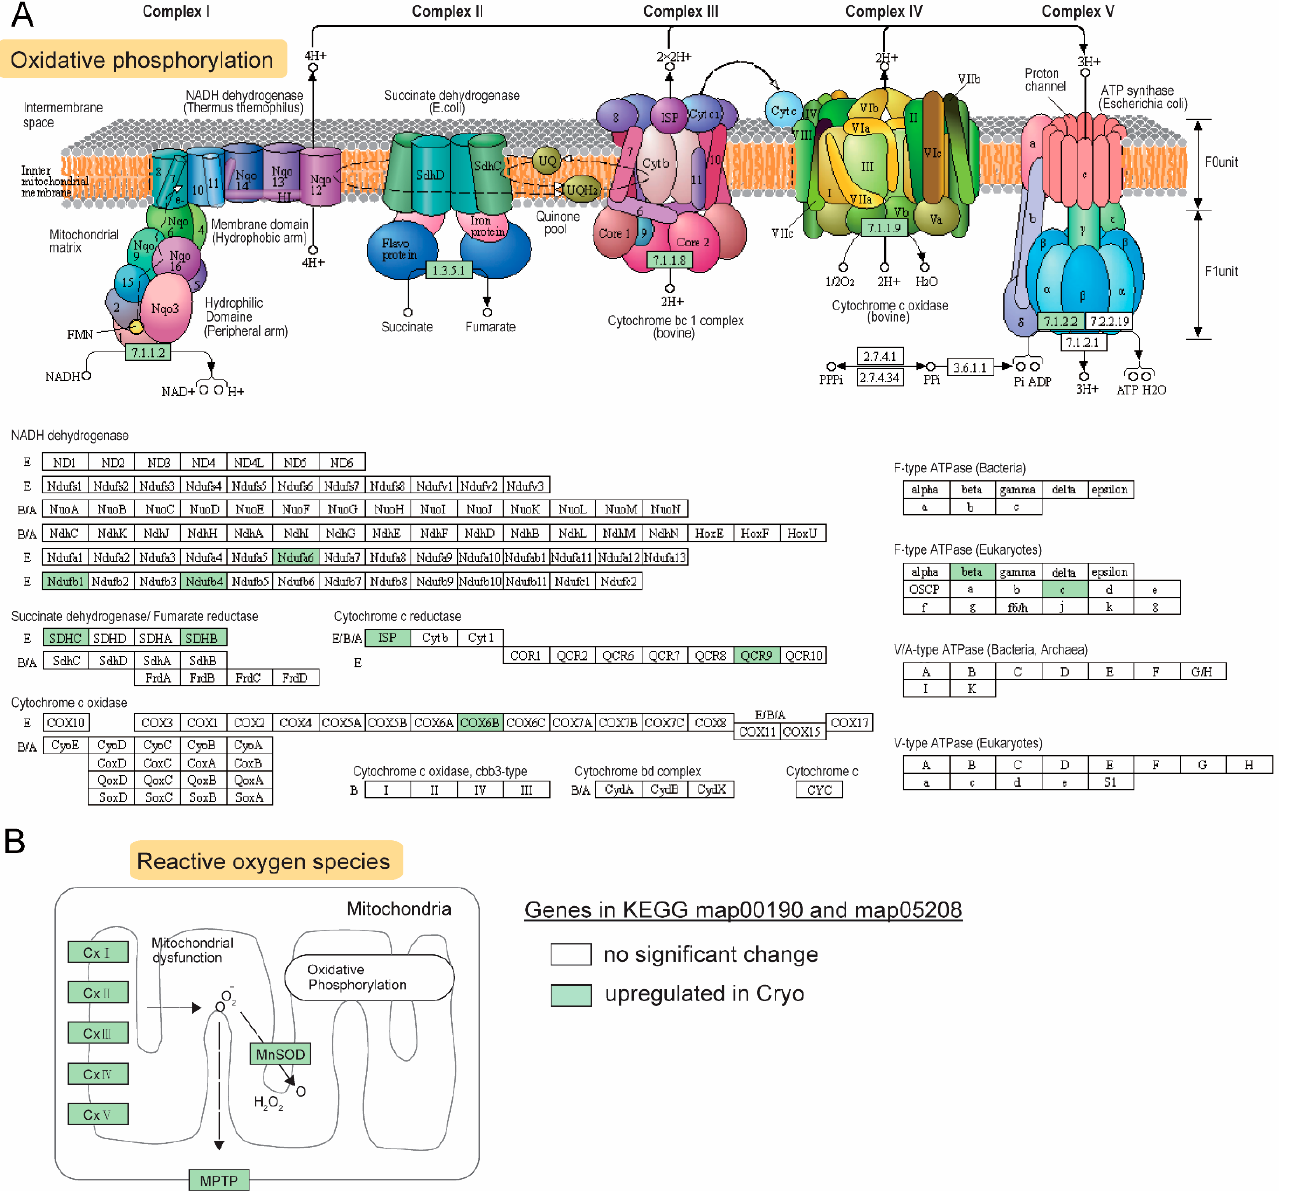
Figure 5. Effects of cryopreservation of sperm on mitochondrial oxidative pathways in blue catfish, Ictalurus furcatus . ( A ) KEGG map of the oxidative phosphorylation pathway in mitochondrial (KEGG ID: map00190). ( B ) KEGG map of chemical carcinogen and reactive oxygen species (KEGG ID: map05208). Upregulated genes, proteins, and enzymes were highlighted in green.